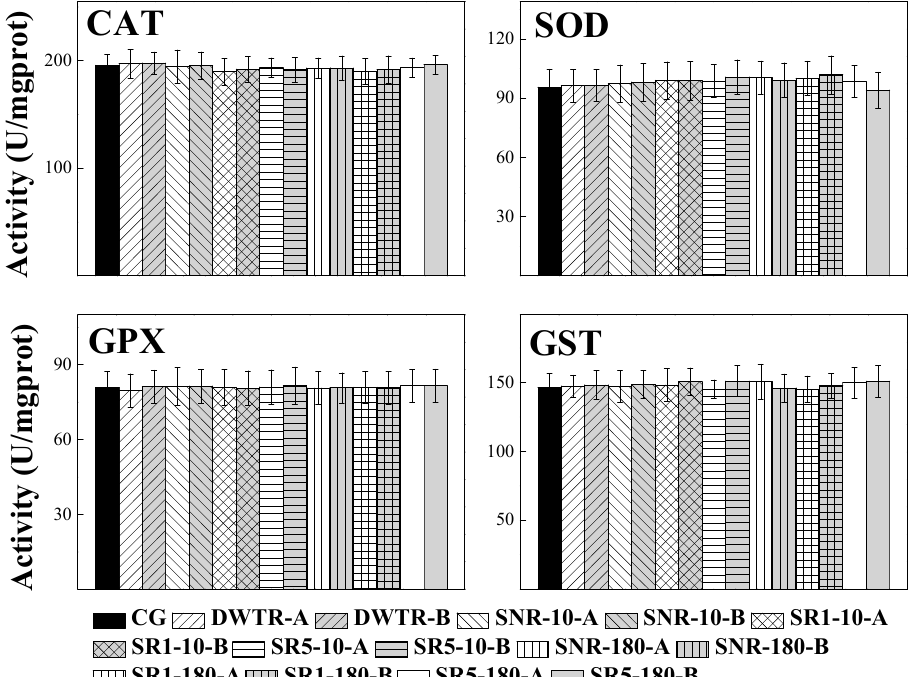
Figure 4. Antioxidant enzyme activities for catalase (CAT), superoxide dismutase (SOD), glutathione peroxidase (GPX), and glutathione-S-transferase (GST) in D. magna . A and B represent the concentrations of treatment culture at 5000 and 500 mg L − 1 , respectively; CG represents the control group.